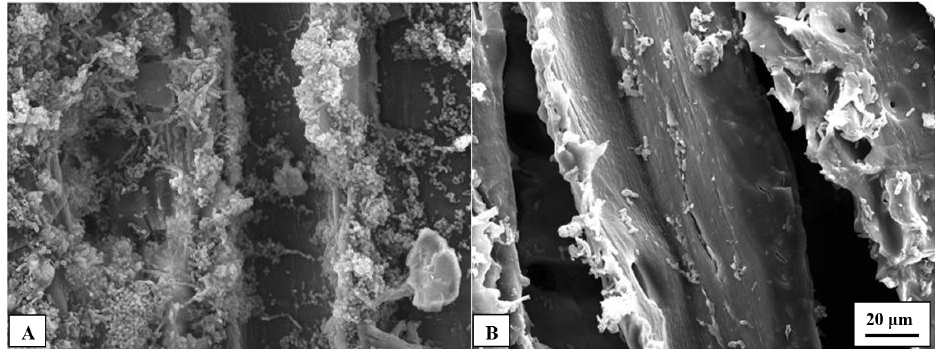
Figure 7. SEM pictures of colonized pine wood veneers after five days of antibiofilm assay. Untreated pine wood veneers ( A ); and enzymatically hydrophobized pine wood veneers ( B ). The pictures were acquired at 1000× magnification.